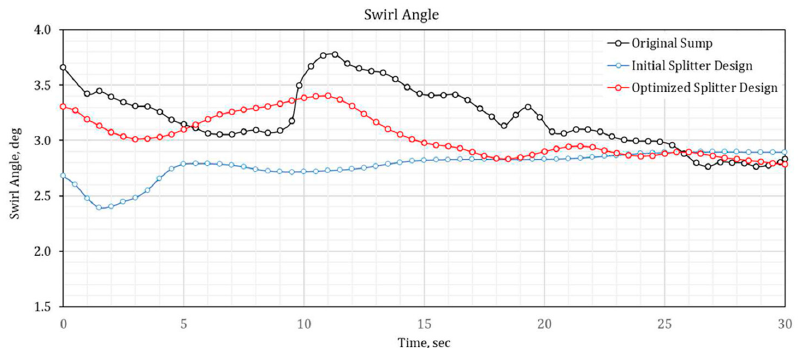
Figure 22. CFD results of swirl angle measurements.